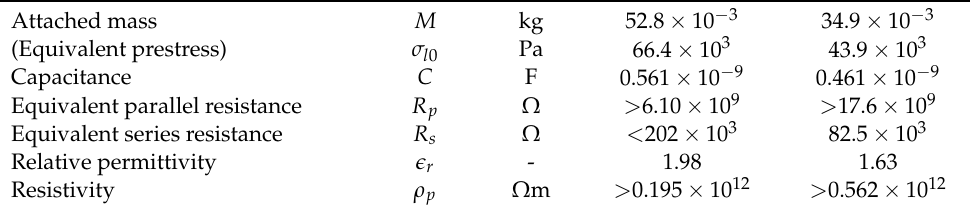
Figure 13. Coherence ( top ), gain ( middle ), and phase ( bottom ) of the experimental frequency response (blue solid line) of the electrical admittance. The identified model Z − 1 also shown. The graph shows the case of weight M = 52.8 g. Table 4. Estimated parameters of the electrical